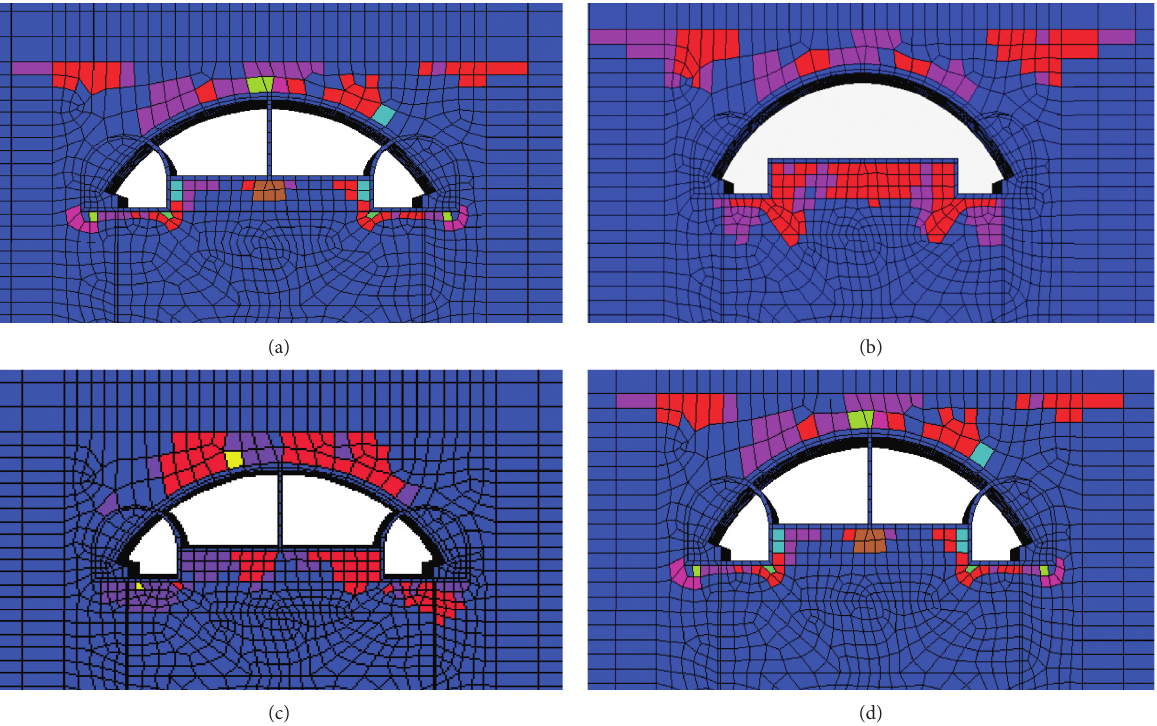
Figure 4: The distribution of plastic zones with different J